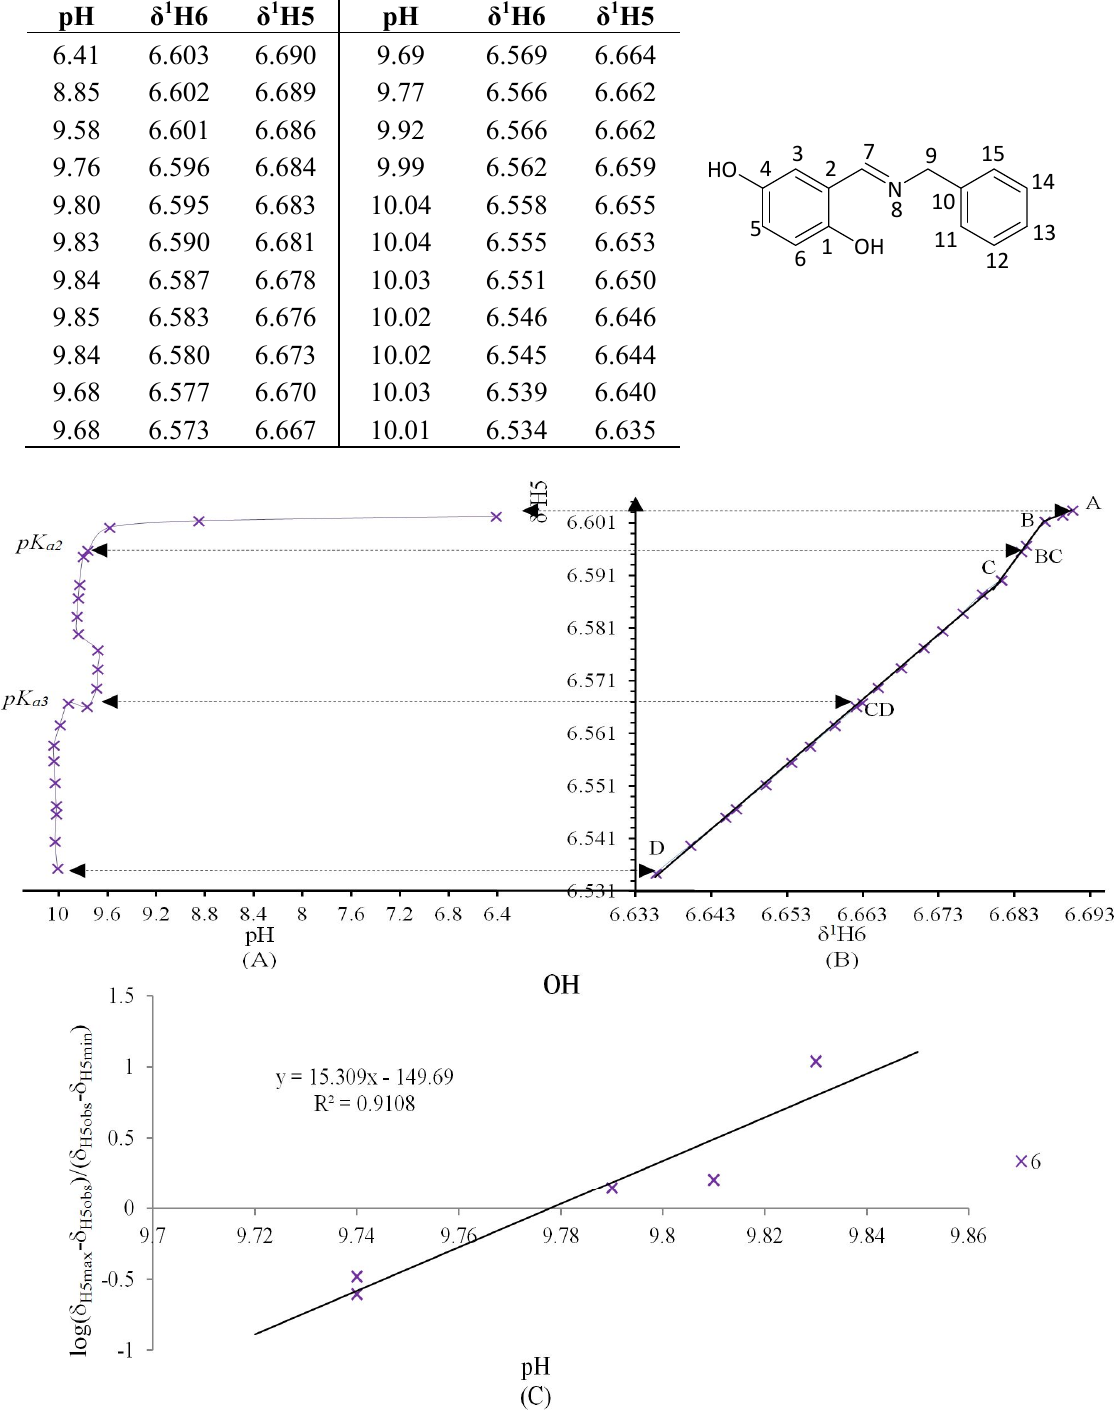
Figure 11. ( A ) titration curve (pH vs. δ 1 H5); ( B ) δ -diagram with